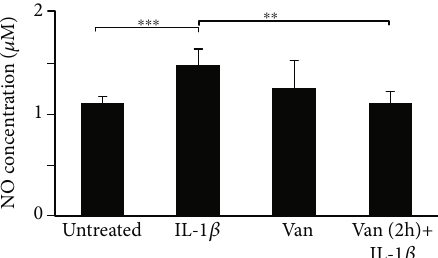
Figure 10: Levels of NO in HGF cells were determined based on Griess reagent reaction. Experiments were conducted in duplicate, and changes were reported as mean ± SD . ∗∗ p < 0 : 01 ; ∗∗∗ p < 0 : 001 . IL-1 β : IL-1 β -primed cells; Van: Vanillin; Van (2 h)+IL-1 β : Vanillin (2 h pretreatment) plus IL-1 β